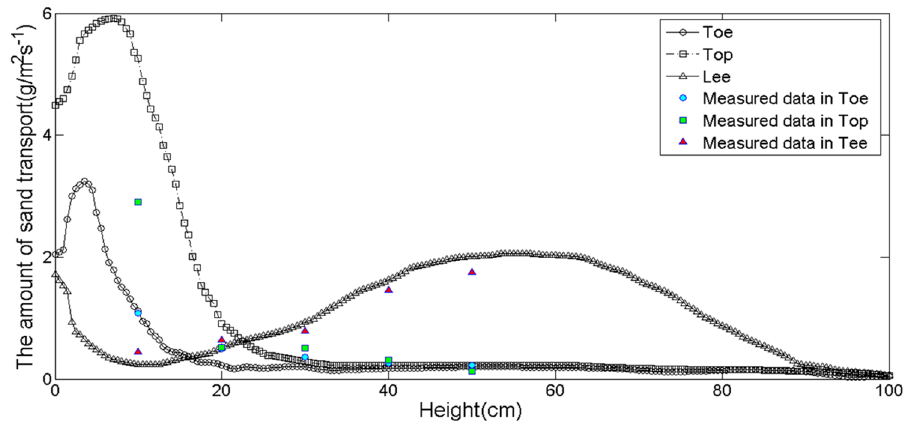
Figure 6. Comparison between the simulated and measured values of sand flux in final form.